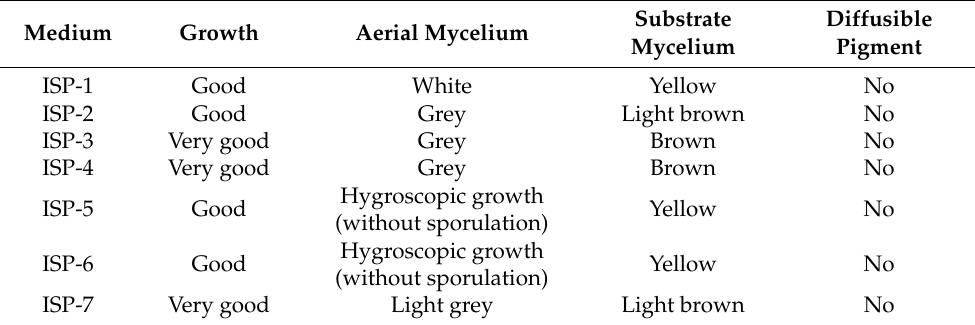
Table 1. MK-104 isolate culture properties on various ISP media.